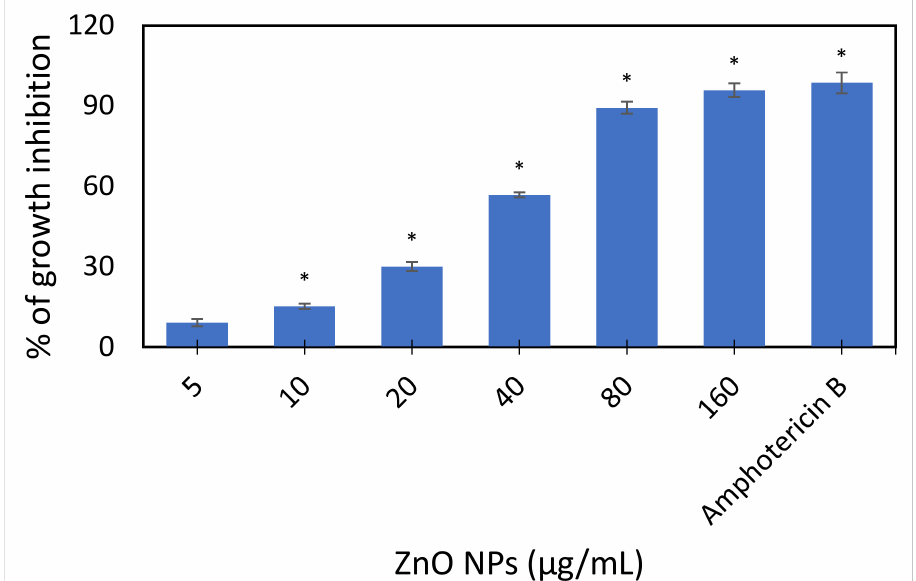
Figure 2. Growth inhibition determined by the turbidity method on C. albicans after treatment with various concentrations of ZnO NPs for 24 h at 35 ◦ C in SDB. An asterisk (*) indicates the significance difference at p < 0.05 between the control and treatments.